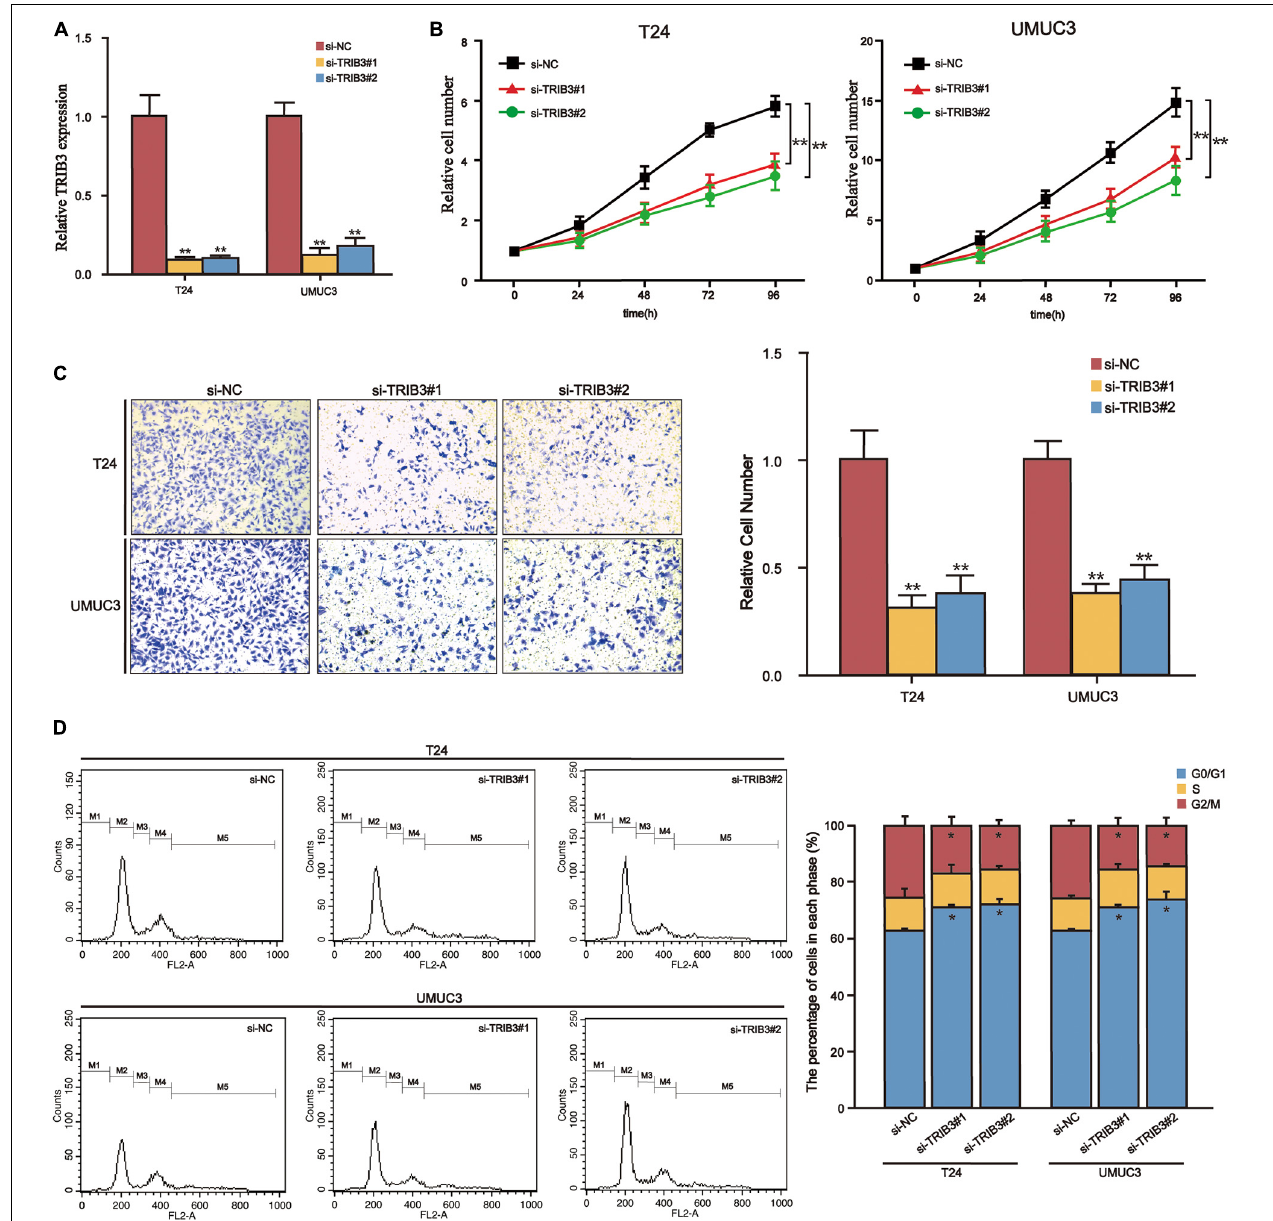
FIGURE 7 | TRIB3-siRNA inhibits the proliferation and migration and induces cell arrest in bladder cancer cells. (A) Relative mRNA levels of control and si-TRIB3 in T24 and UMUC3 cells. (B) The CCK-8 assay results showed that T24 and UMUC3 cells’ proliferation ability decreased when treated with si-TRIB3. (C) The invasion assay shows that the invasive ability of T24 and UMUC3 cells treated with si-TRIB3 decreased. (D) G0/G1 phase arrest of bladder cancer after TRIB3 siRNA transfection, confirmed by statistical analysis. * P < 0.05 and ** P <